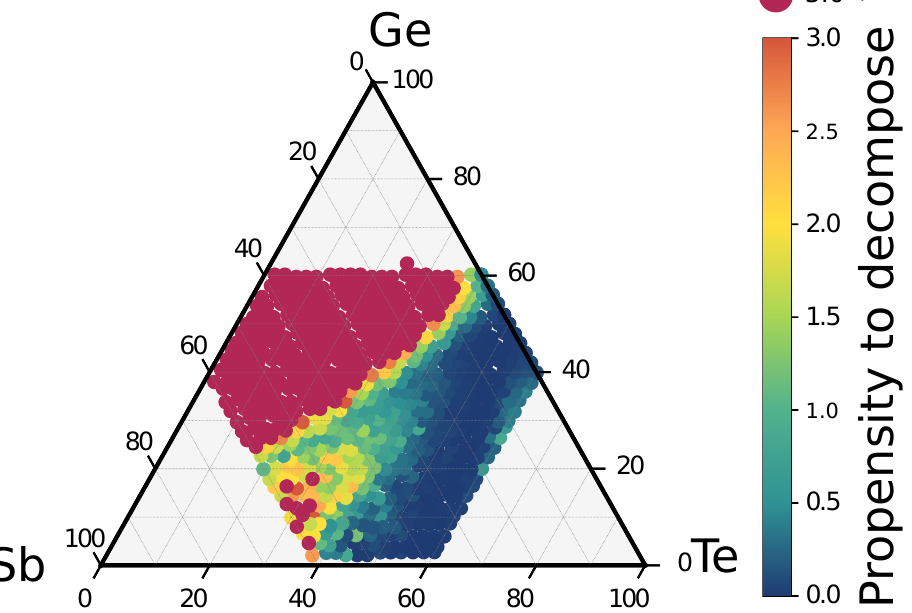
Figure 5. Map of the decomposition propensity of the cubic phase of GST alloys on the ternary phase diagram (see text). Low values (blue region) indicate a low propensity to decompose. The decomposition propensity is computed by counting the exothermic decomposition channels weighted by the modulus of their reaction free energy (in